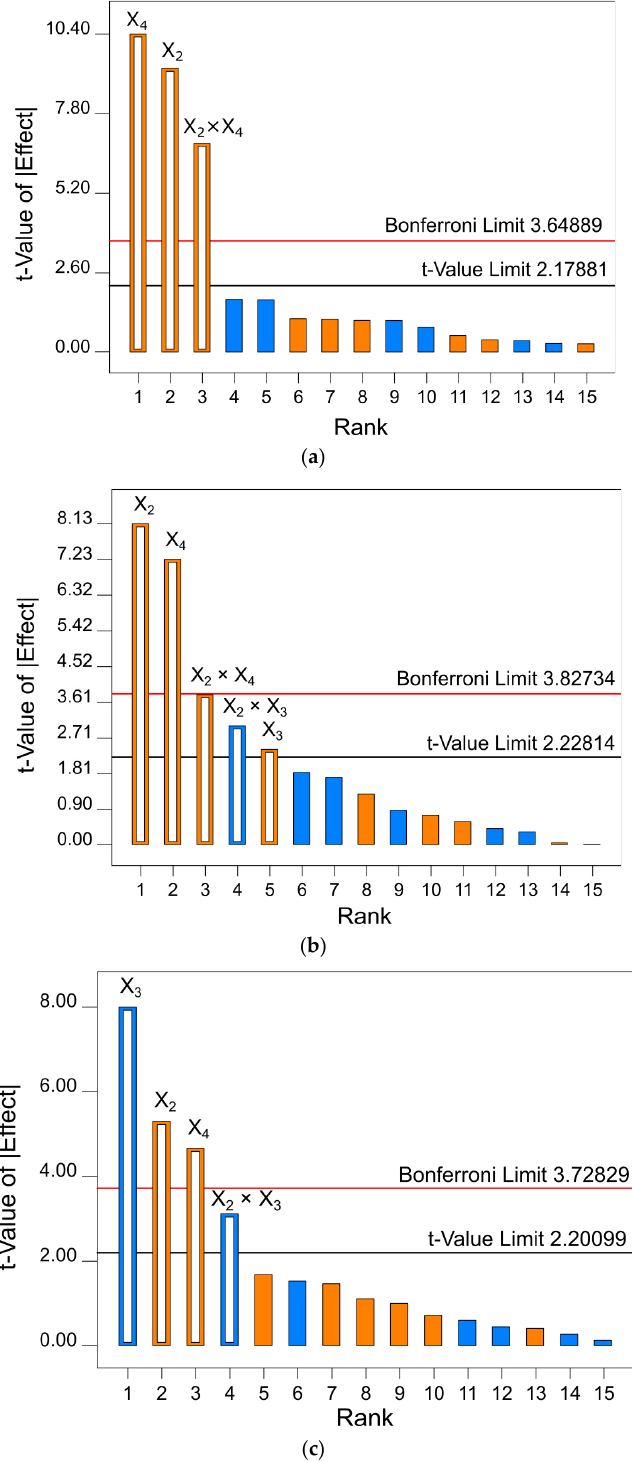
Figure 3. Pareto charts for the selected models of total ( a ) phenolic compounds, ( b ) phenolic acids, and ( c ) flavonoids extraction. Independent variables: X 1 = ultrasonication power, X 2 = temperature, X 3 = lactic acid content, X 4 = herbal material/solvent weight ratio, X 5 = glycerol content. Blue color on the chart ( a ) indicates a negative, and orange color a positive, effect of independent